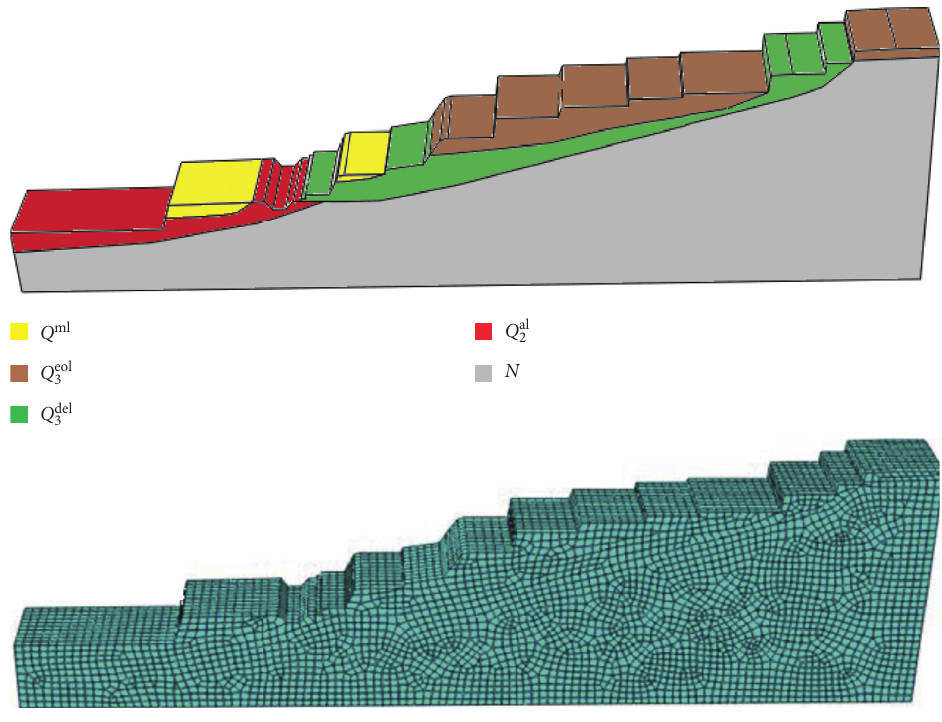
Figure 10: The finite element model and the soil material interface.